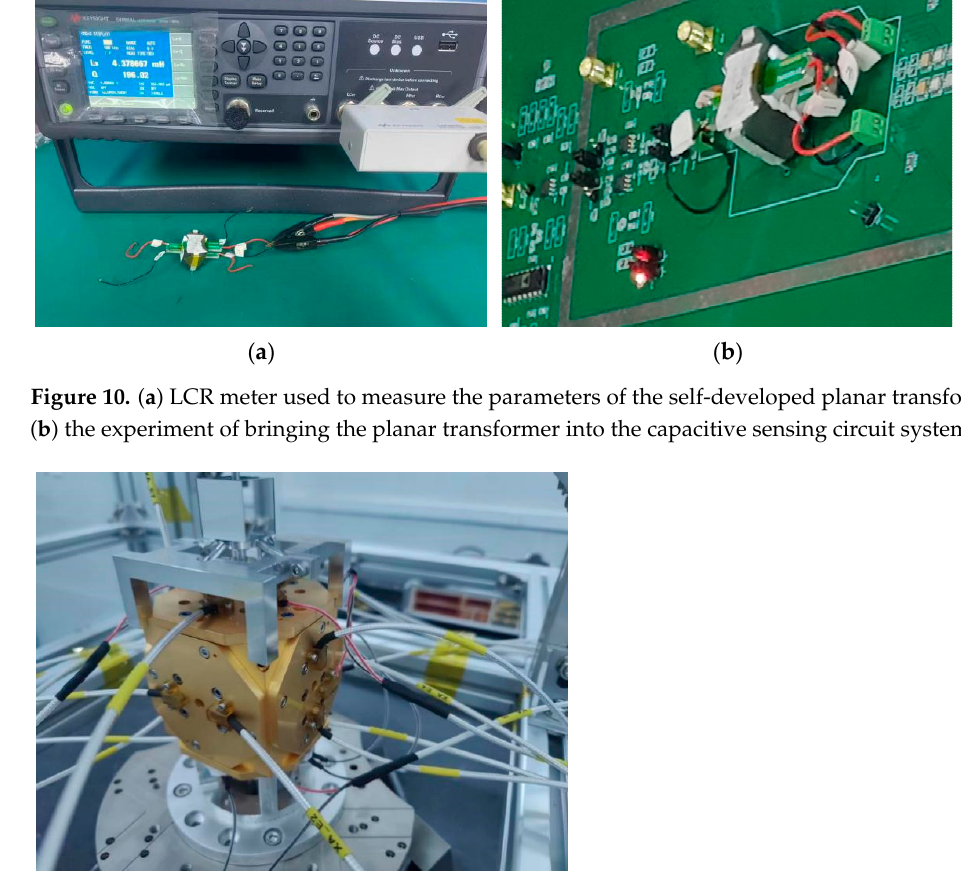
Figure 11. Physical map of the ground test of sensitive structures.